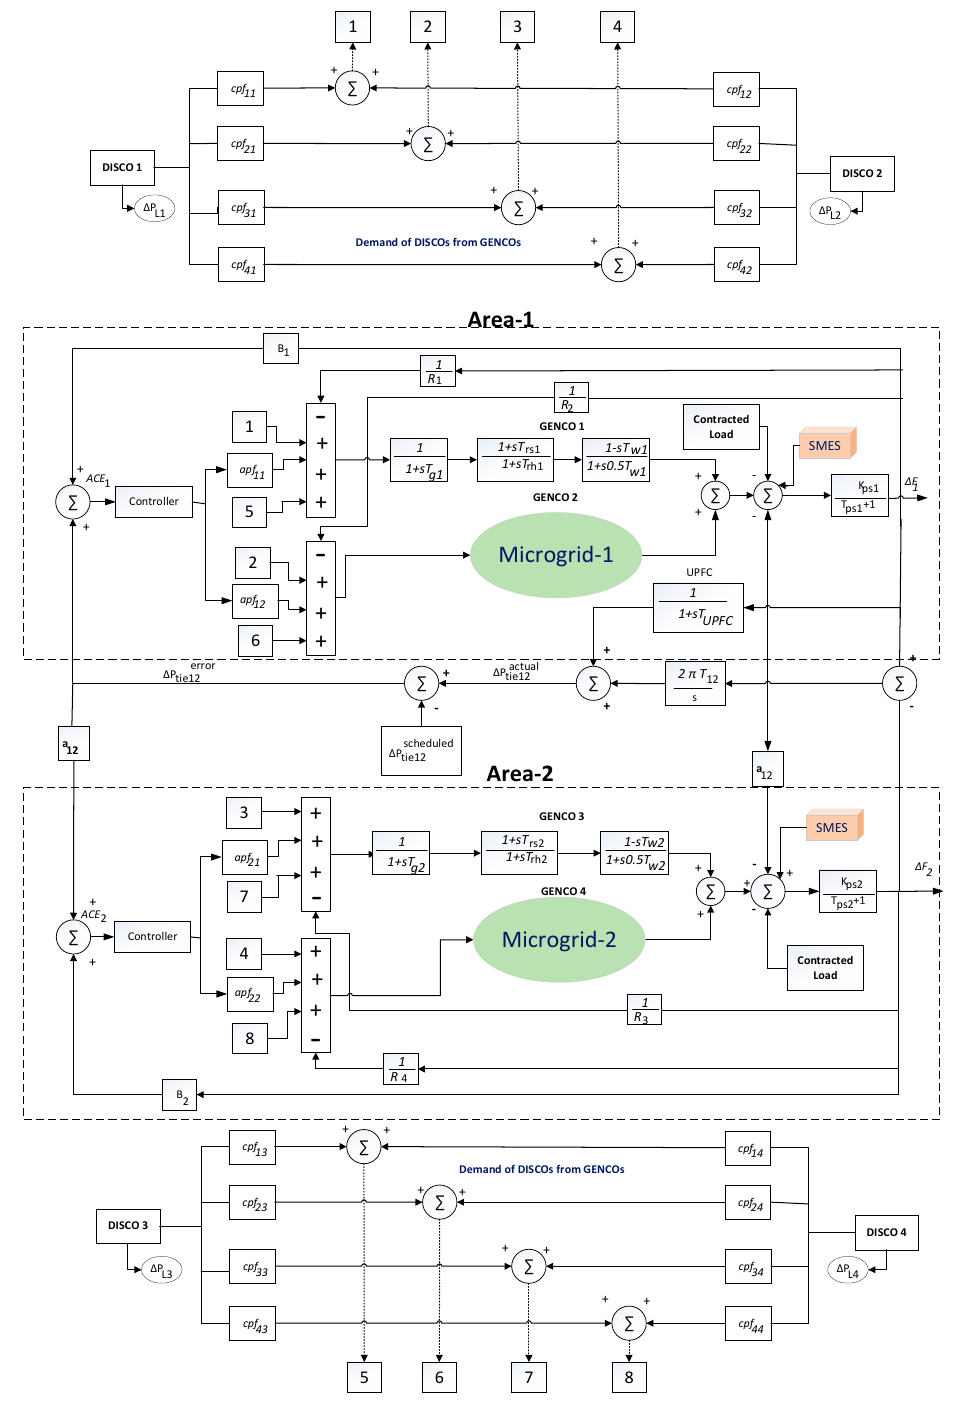
Figure 4. Transfer function model of the deregulated power system. Thus, the error of the tie-line power exchange at any instant, indicated by ∆ P error implicates the area control error (ACE) in the particular area, presented in (6) [31].